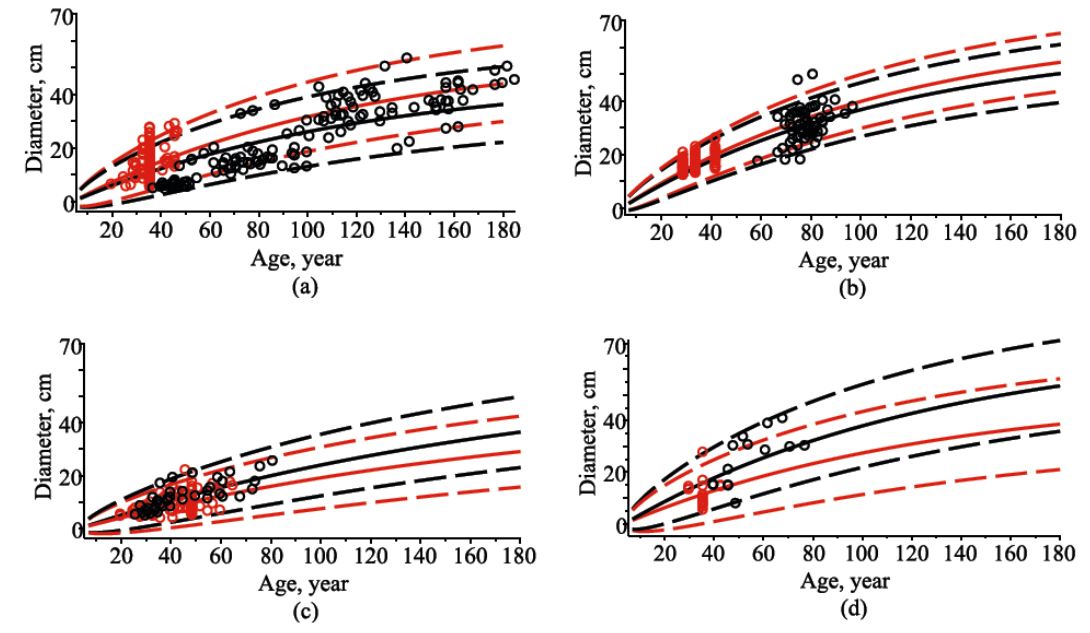
Figure 2. Kinetics of the mean, 0.05 quantile, and 0.95 quantile of the diameter for two randomly selected stands from a validation dataset: ( a ) all species; ( b ) pine ( Pinus sylvestris ); ( c ) spruce ( Picea abies) ; ( d ) silver birch ( Betula pendula Roth and Betula pubescens Ehrh.); solid line — mean trajectory; dashed line — quantile trajectories; black — first stand; red — second stand; and circle — observed data.